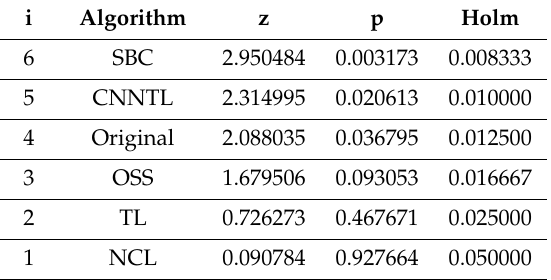
Table 26. Results of the Holm test comparing the performance of the SNDAM classifier after undersampling algorithms. The test rejects the hypothesis having an unadjusted p -value ≤ 0.01.